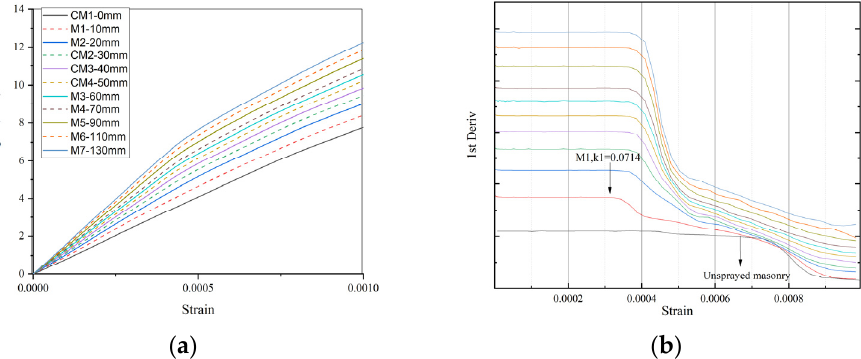
Figure 15. ( a ) Stress-strain curves of the simulation results in the elastic phase, and their; ( b ) Differential curves